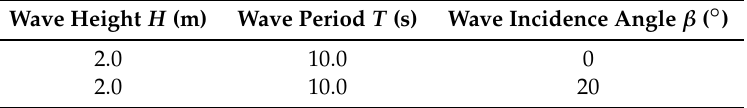
Table 2. WEC farm regular wave modelled scenario.